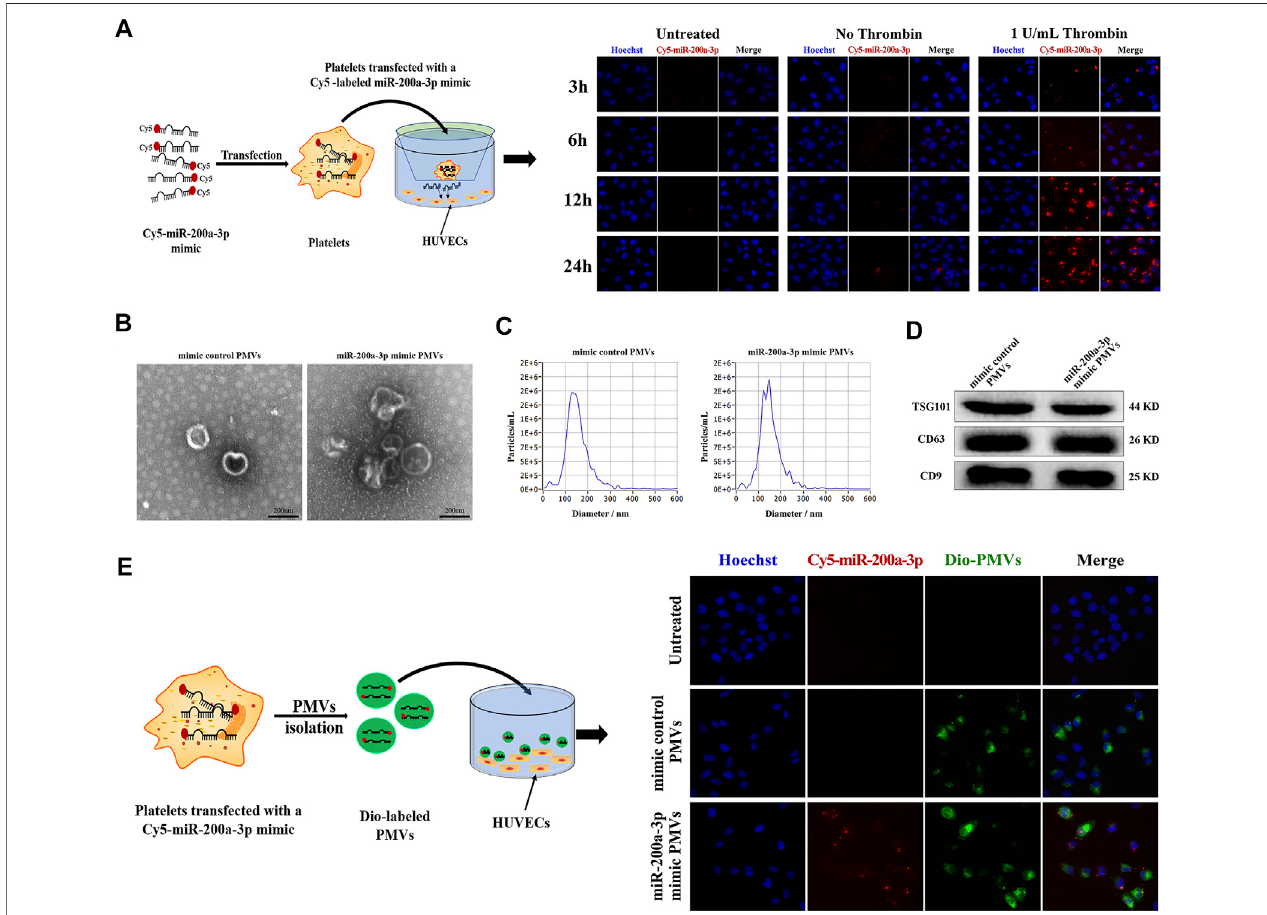
FIGURE 6 | Effective delivery of platelet miR-200a-3p into HUVEC by PMVs. (A) Representative fl uorescence images of HUVEC after 3, 6, 12 and 24 h co-culture with Cy5-labeled miR-200a-3p mimics (red) transfected platelets in the presence or absence of 1 U/mL thrombin at 37 ° C. Nuclei were stained blue. (B) Representative transmission electron microscopy images of PMVs isolated using ultracentrifugation (scale bar, 200 nm). (C) The size distribution and concentration of isolated PMVs measured by Nanoparticle Tracking Analysis. (D) The PMVs speci fi c markers TSG101 and CD63, and CD9 were detected by western blot analysis. (E) After plateletsweretransfectedwithmimiccontrolorCy5-labeledmiR-200a-3pmimic(red),PMVswereisolatedbyultracentrifugation.Representative fl uorescenceimagesof HUVEC incubated with DiO green fl uorescence-labeled PMVs in the presence of 1 U/mL thrombin for 24 h at 37 ° C. Nuclei were stained blue.